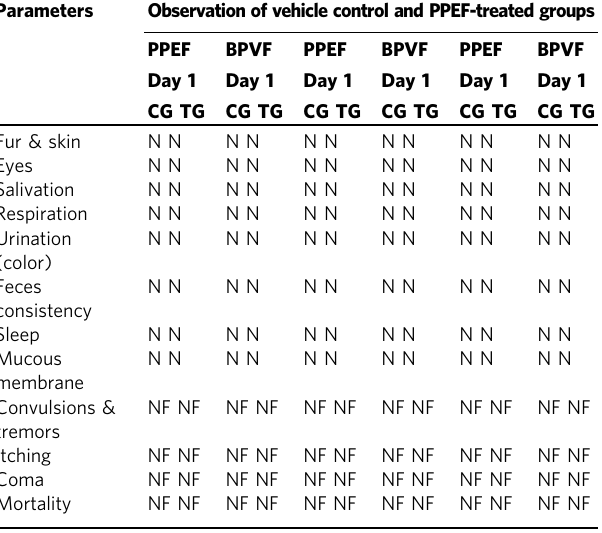
Table 3 Behavioral patterns of PPEF and BPVF injected in a group of mice. Parameters Observation of vehicle control and PPEF-treated